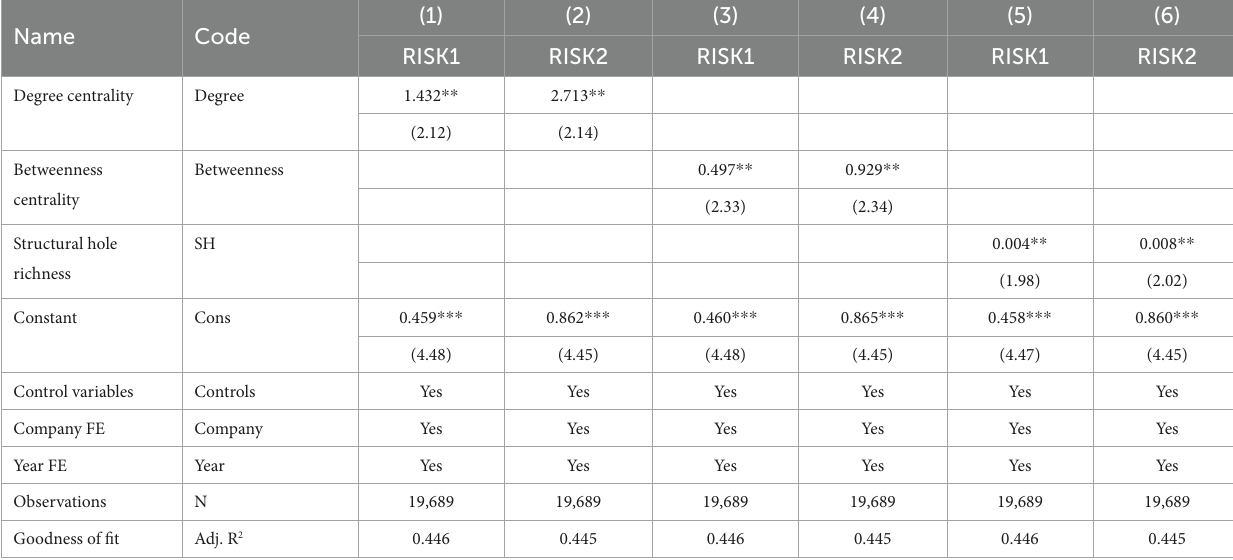
TABLE 8 Two-way cluster analysis of company and